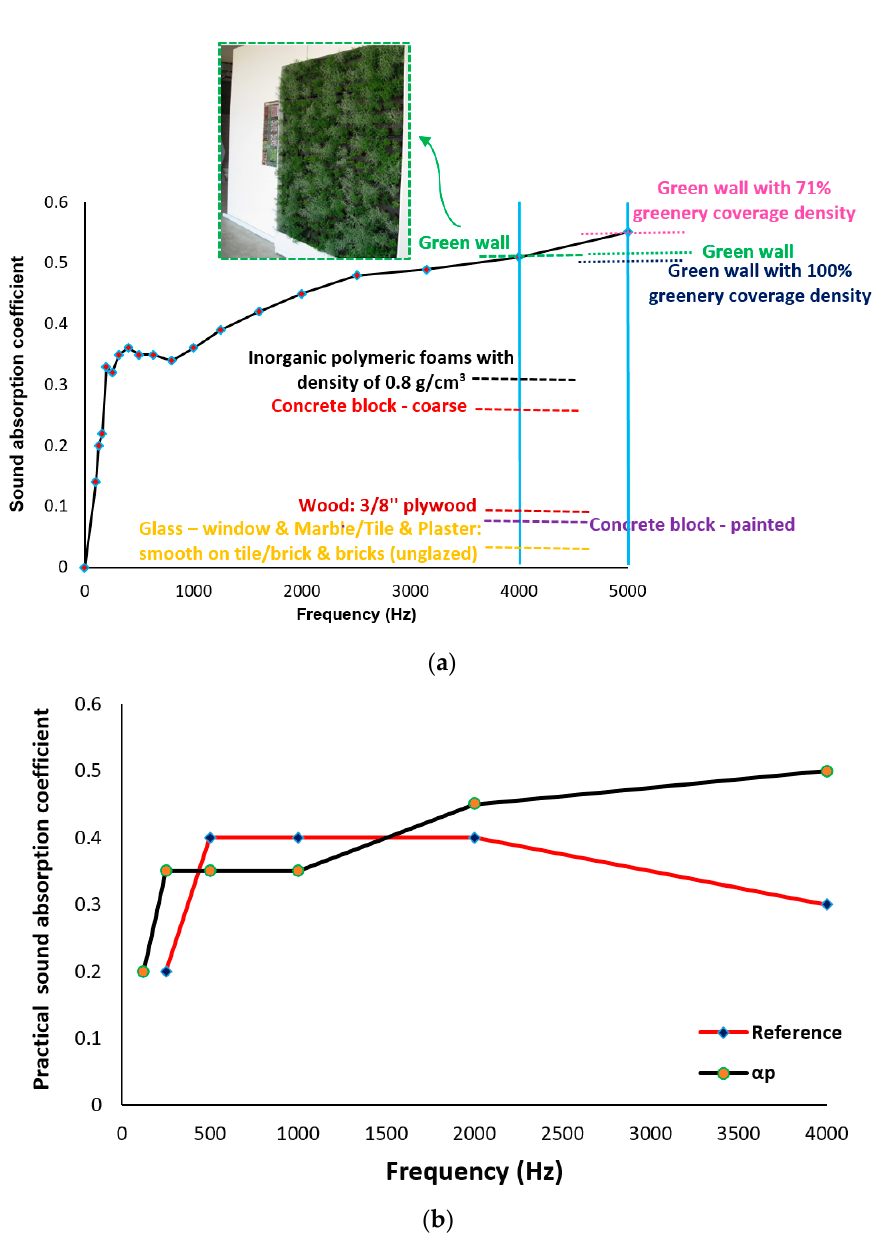
Figure 16. ( a ) The sound absorption coefficient; ( b ) the practical sound absorption coefficient.